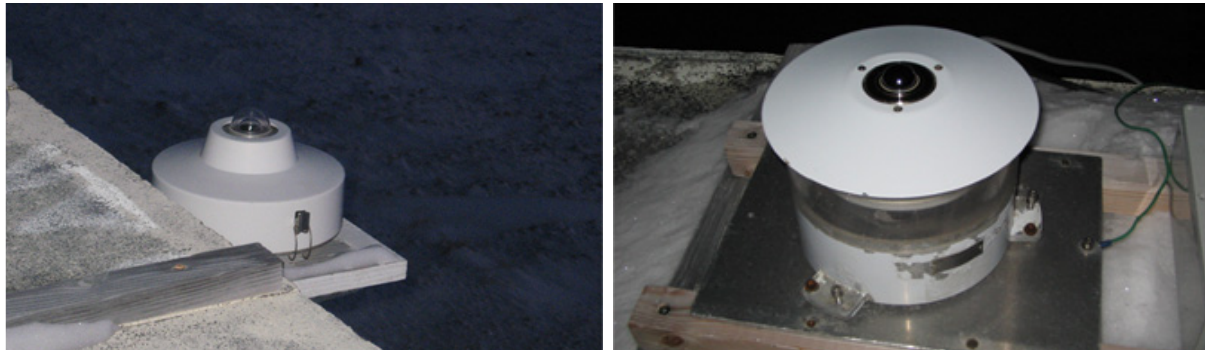
Figure 4. The TSP-700 and the PIR 33499 installed on the roof of buiding